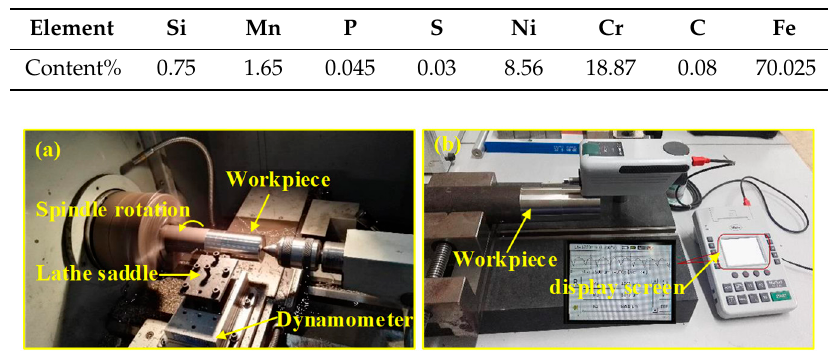
Table 4. Experimental data.